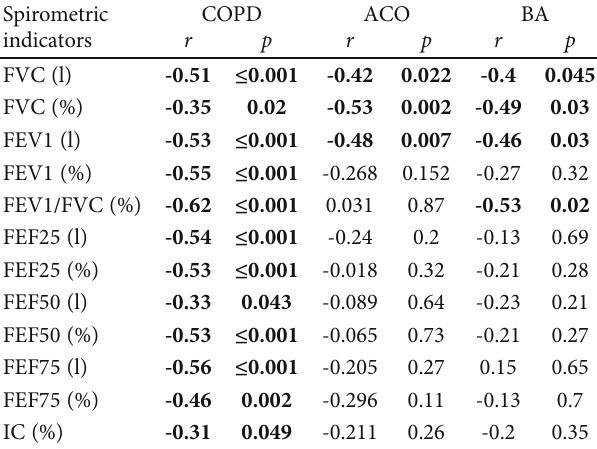
Table 4: Correlation between the serum concentration of IL-18 and the lung function parameters in patients with COPD, asthma- COPD overlap, and bronchial asthma. Spirometric indicators